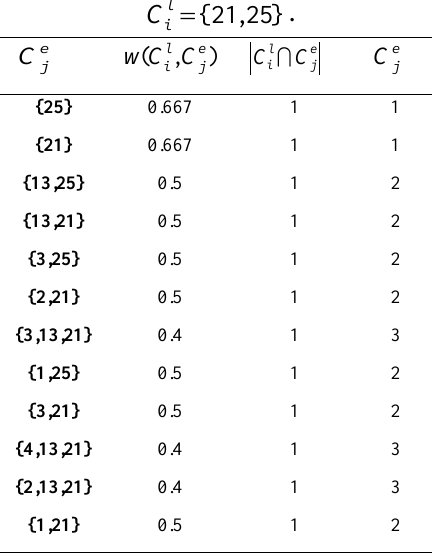
Table 3. Attributes having common codes